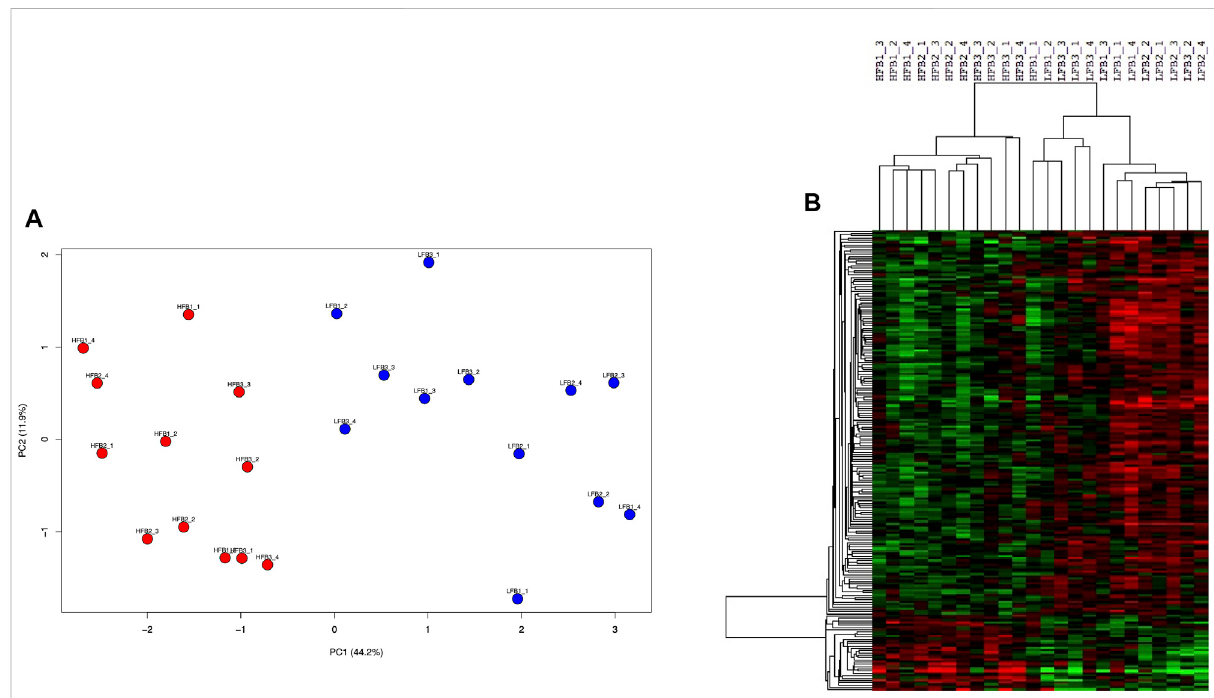
FIGURE 8 Discriminative endometrial genes for high fertility (HF) or low fertility (LF) groups selected by a supervised analysis. The 200 genes were identi fi ed through sparse-partial least square-discriminant analysis. (A) Principal component analysis of the HF and LF samples plotted according to the gene expression. (B) Hierarchical clustering and heat map of the selected genes. RNAseq data from endometrial explants exposed to a Day 15 conceptus from a HF or LF